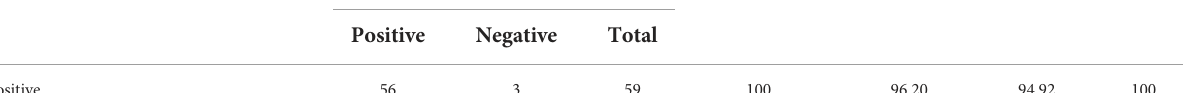
TABLE 3 Comparing C. trachomatis levels in clinical samples using our MCDA-AuNPs-LFB assay with a qPCR